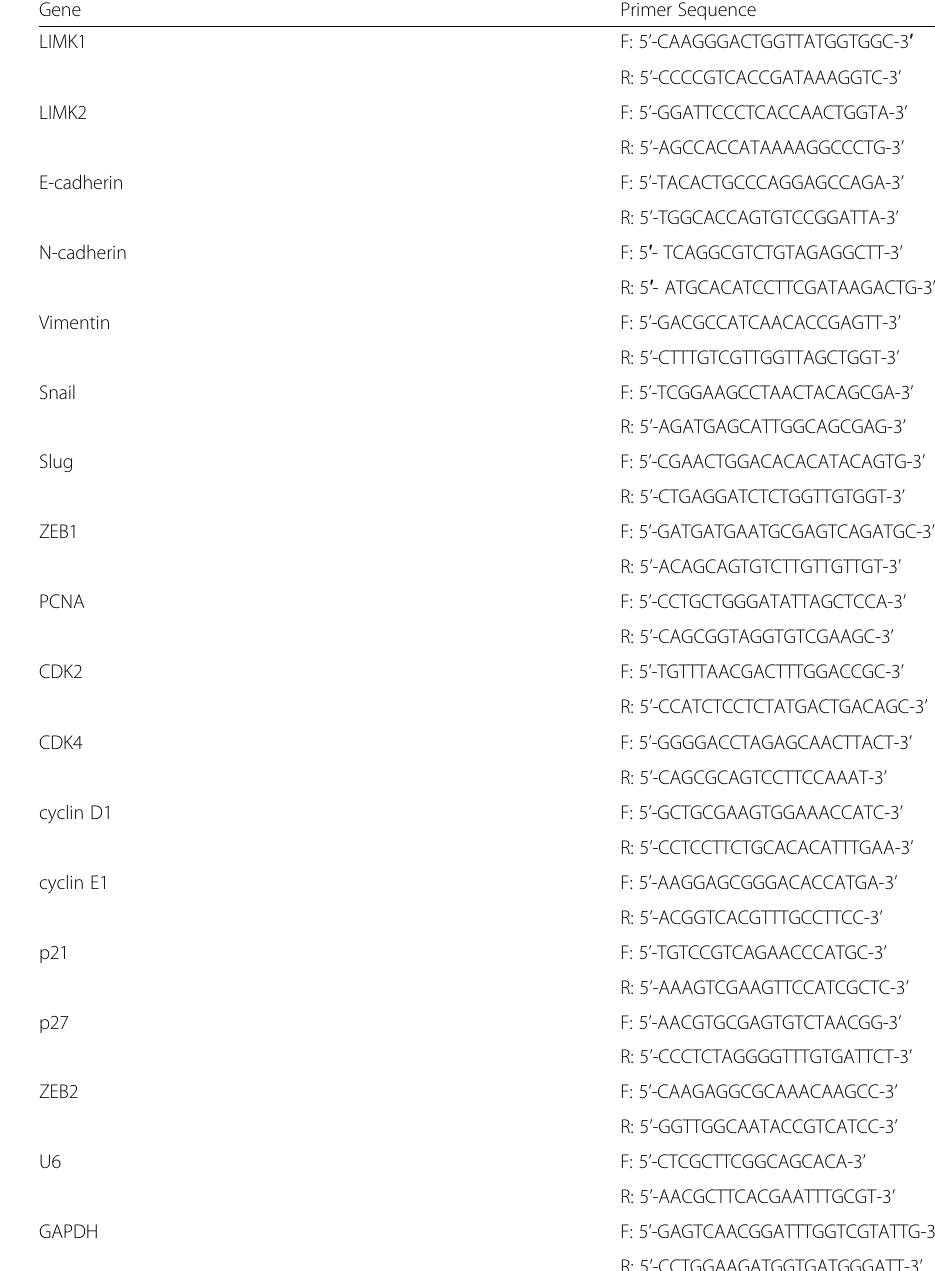
Table 1 Sequence of primers for qRT-PCR